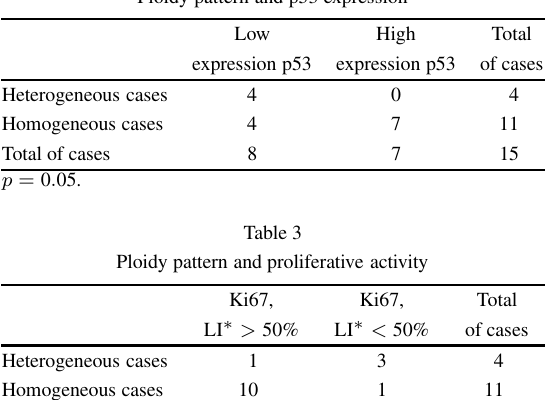
Ploidy pattern and p53 expression